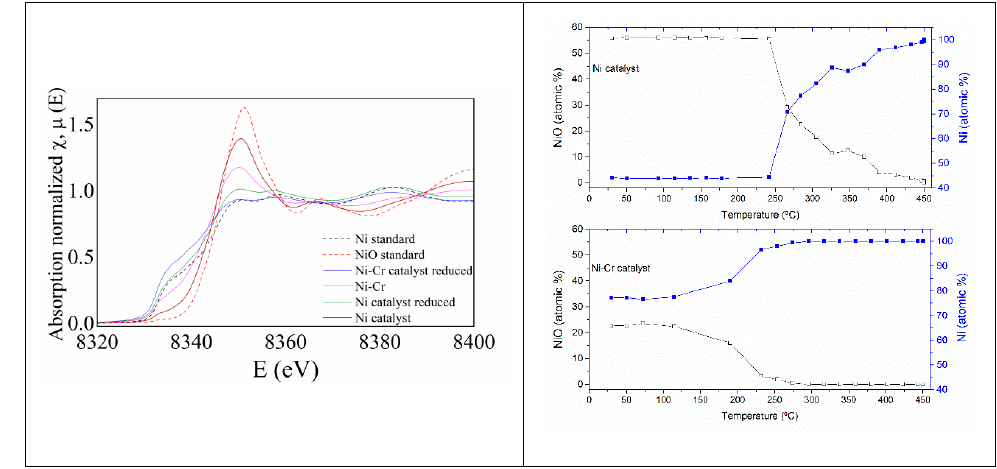
Figure 4. Ni K XANES of both Ni-based catalysts before and after in-situ temperature programmed reduction (TPR). Ni and NiO standards are shown for comparision ( left ). The results of the linear combination analysis of the XANES data taking during the TPR ( right